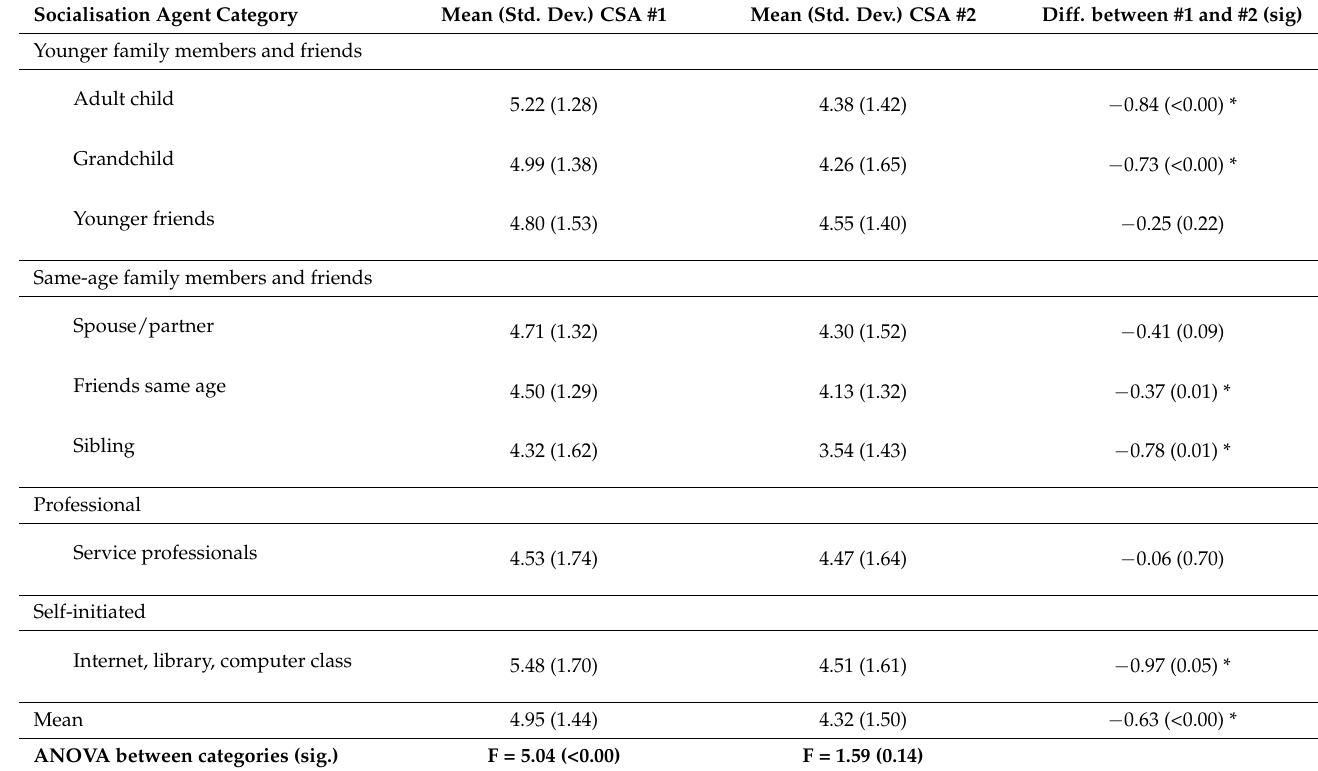
Table 2. Relative strength of CSA received from categories of